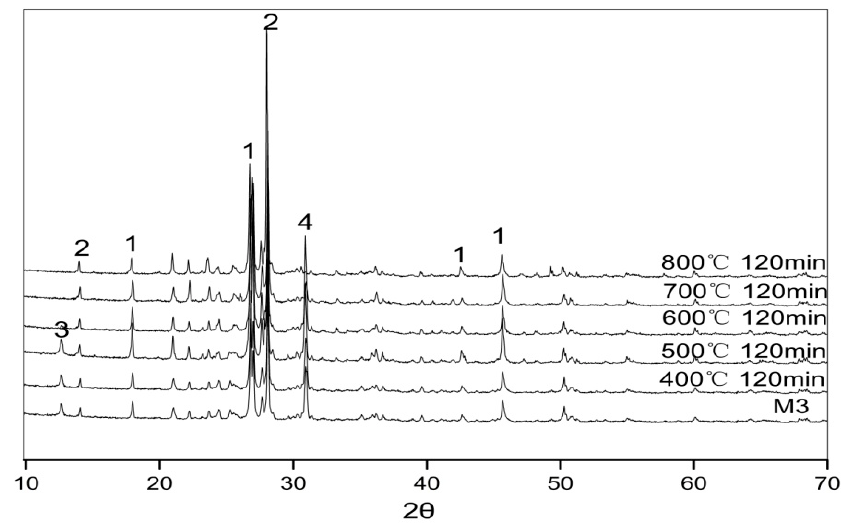
Figure 13. XRD patterns of the thermally activated conditions of copper tailings (1 quartz, 2 albite, 3 chlorite, 4 dolomite).